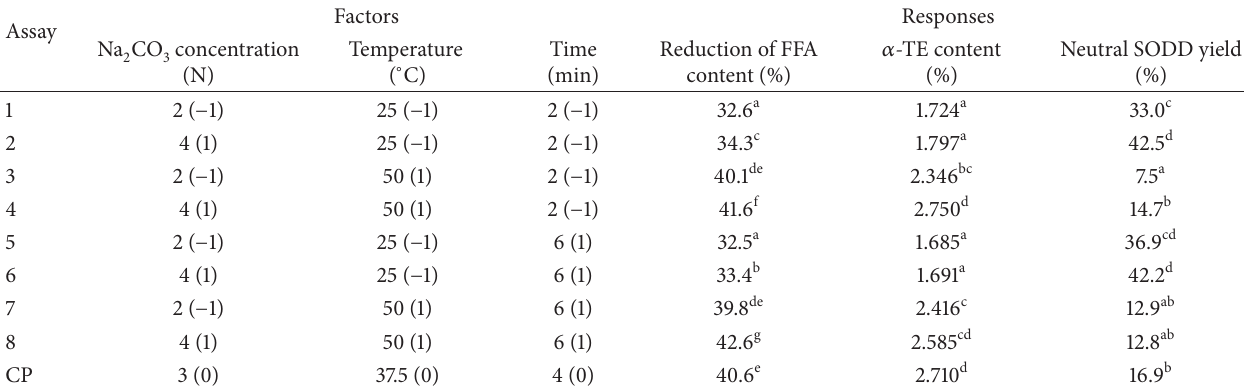
Table 2: First experimental design matrix with real and coded variables’ values and studied responses.